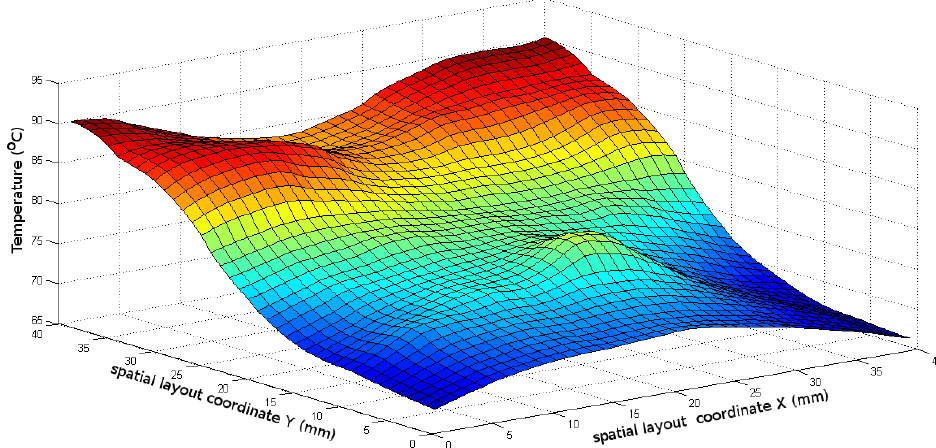
Figure 10. Temperature profile for DTM constraints T c = 80 ◦ C, T h = 100 ◦